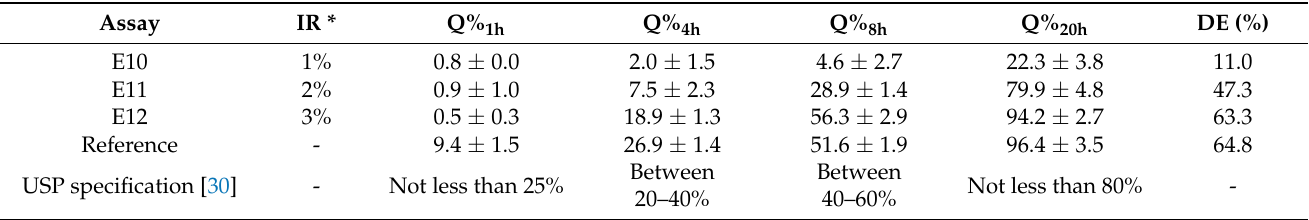
Table 6. Percentage of drug dissolved (Q) and dissolution efficiency (DE%) of the MS, obtained for the additional formulations and its reference, Selopress Zok ® . The values for percentage of drug dissolved of the mini-tablets are expressed by the average of three determinations, and for the reference drug product by the average of 12